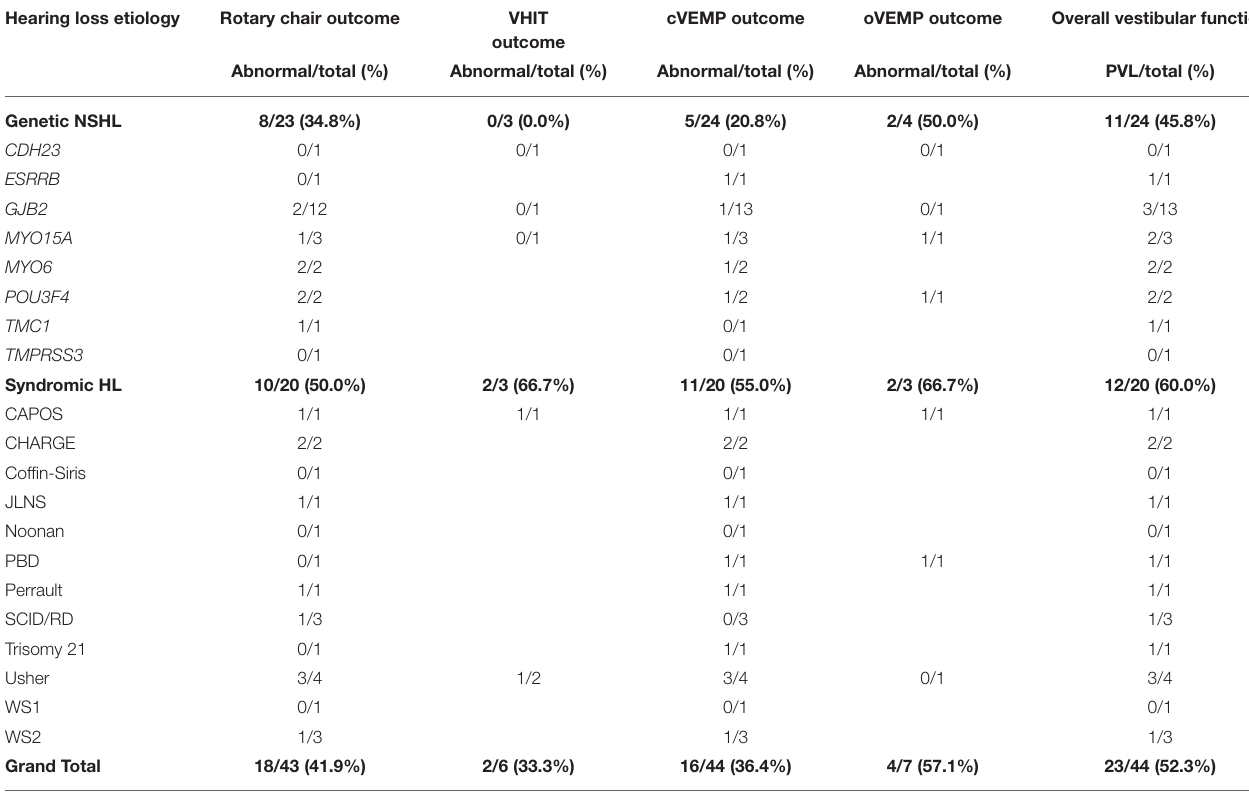
TABLE 2 | Results of vestibular testing in all patients with genetic hearing loss ( n =